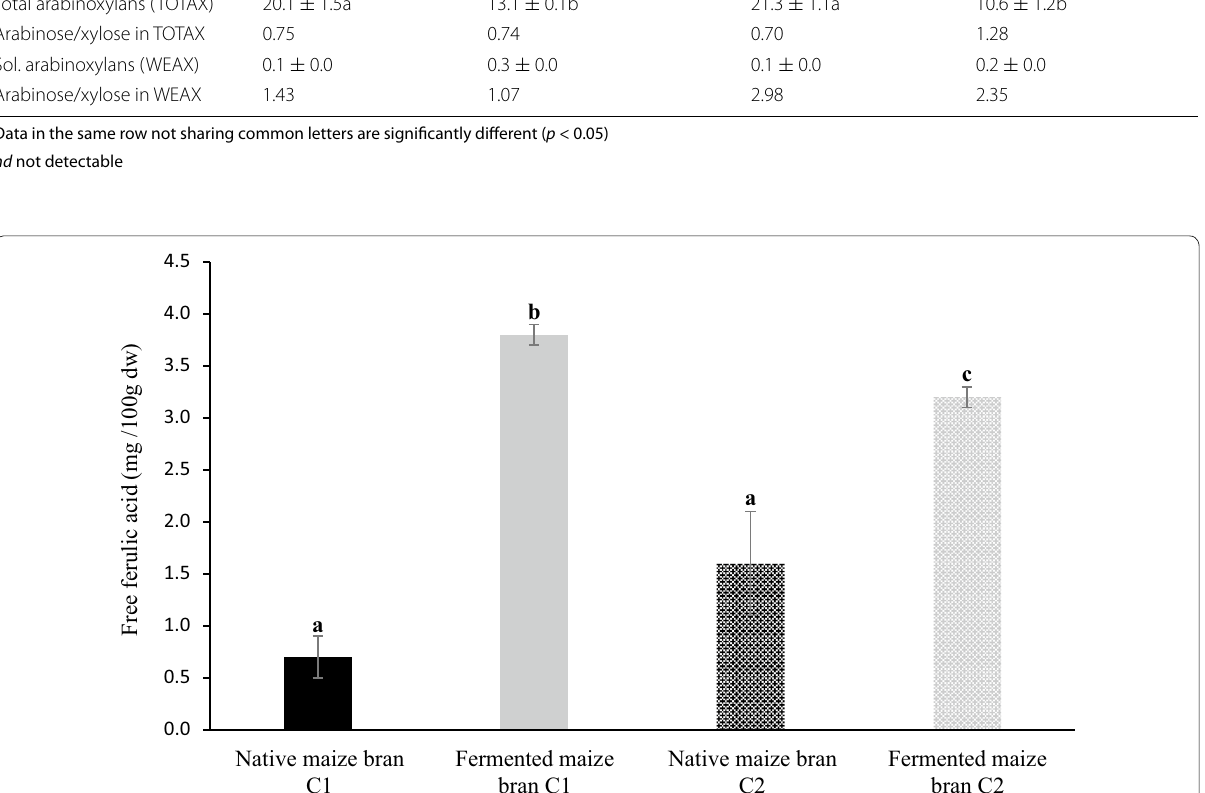
Fig. 4 Free ferulic acid (mean SD; expressed as mg/100 g of dry weight) content in native and fermented (refreshment 12) brans. Bars not shar- ± ing common letters are significantly different ( p <